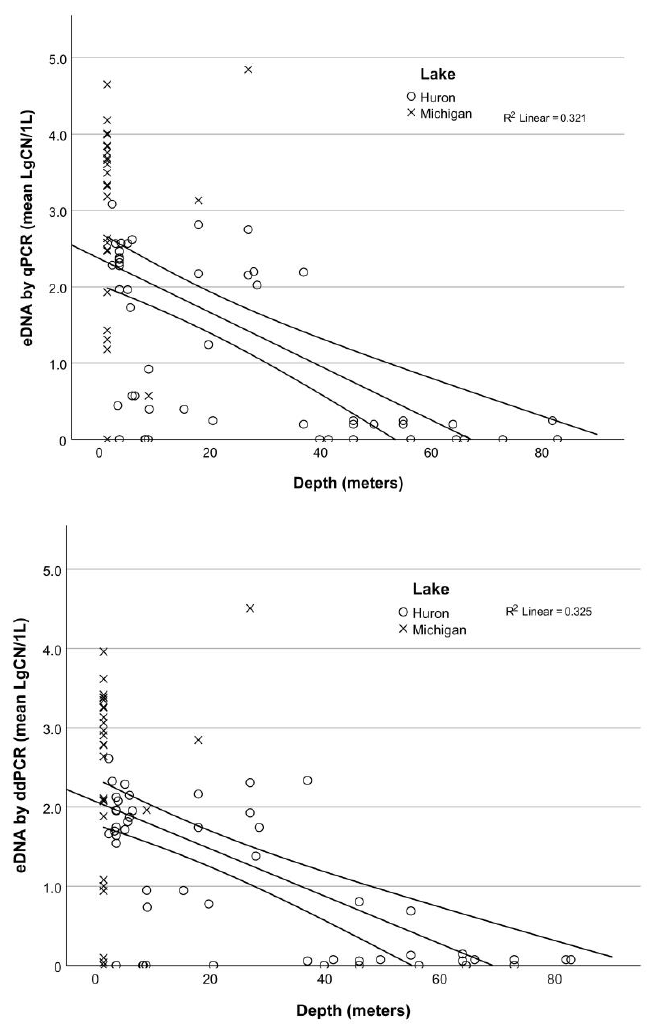
Figure 5. Round goby ( Neogobius melanostomus ) eDNA concentrations (log 10 copy numbers per liter (CN/L)) detected by quantitative PCR (qPCR, top ) and droplet digital PCR (ddPCR, bottom ) at different depths in Lake Huron and Michigan. Lines represent linear fit with 95% confidence intervals.